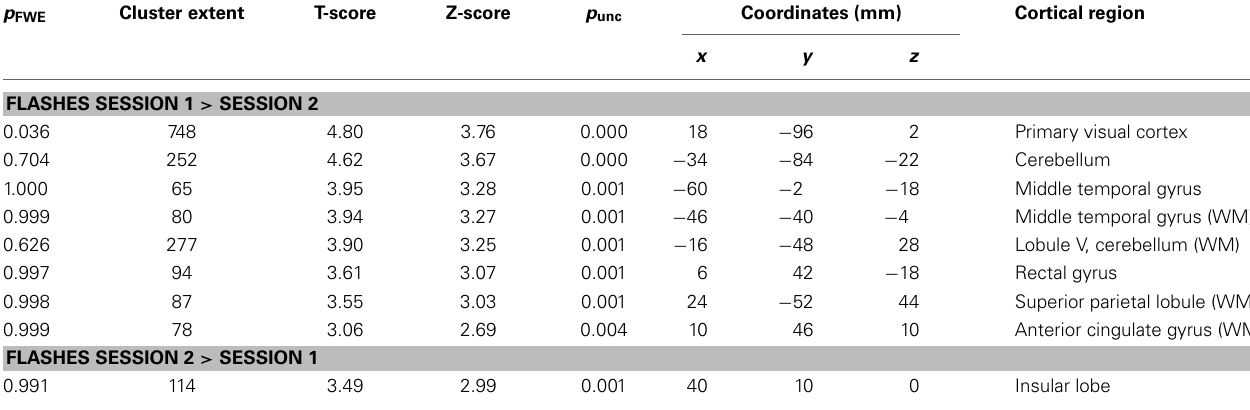
Table 1 | Group-level between session effects.